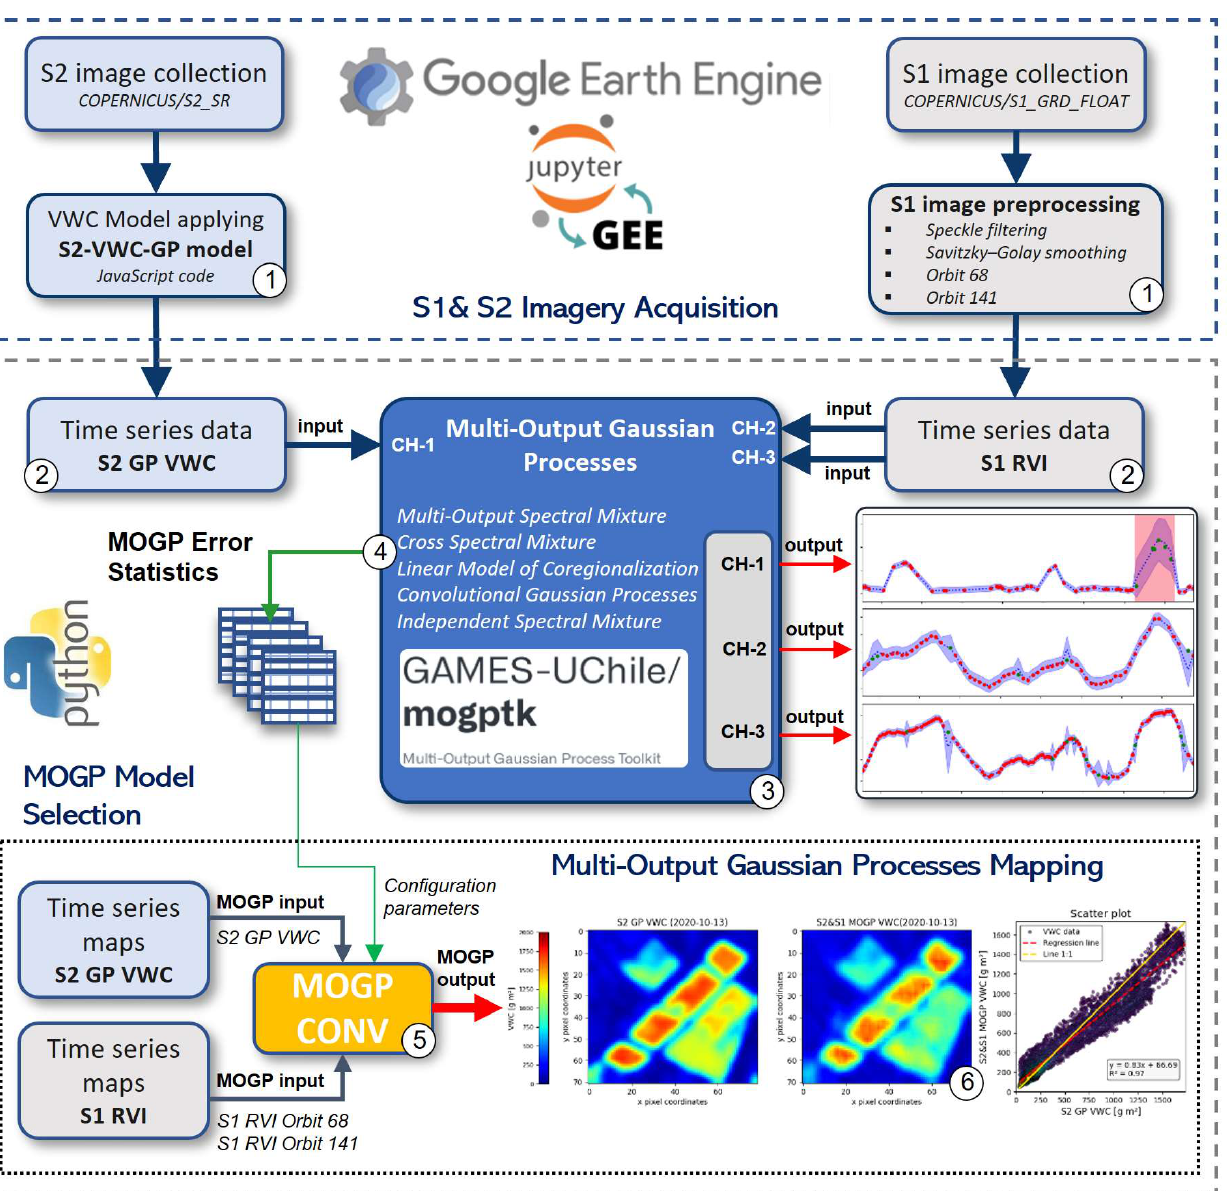
Figure 2. Illustration of the processing workflow to obtain maps of vegetation water content over irrigated winter wheat, as described in Section 2.7. The ordinal numbers in the graph refer to the workflow processing steps. The maps show the output obtained by our MOGP VWC models over the BVCR study site in